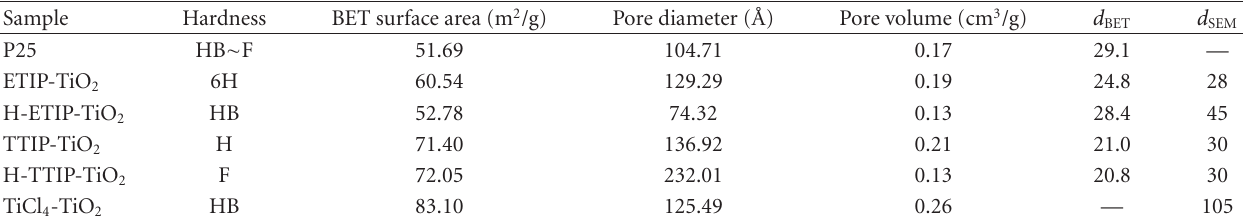
Table 1: Comparison of di ff erent preparation methods for titanium dioxide nanoparticle colloidal paste from TiCl 4 .